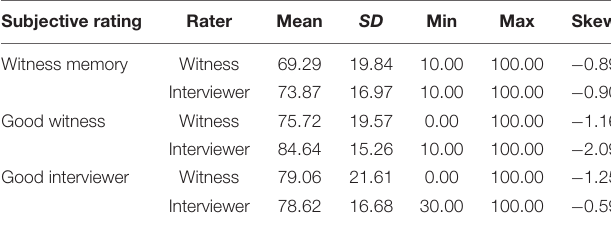
TABLE 2 | Descriptive statistics of percentage endorsement of witness memory, witness interview skill and interviewer score. Subjective